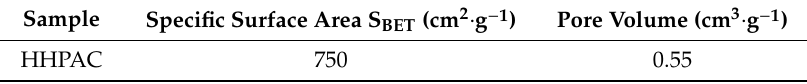
Table 1. The specific surface area and pore volume of HHPAC.